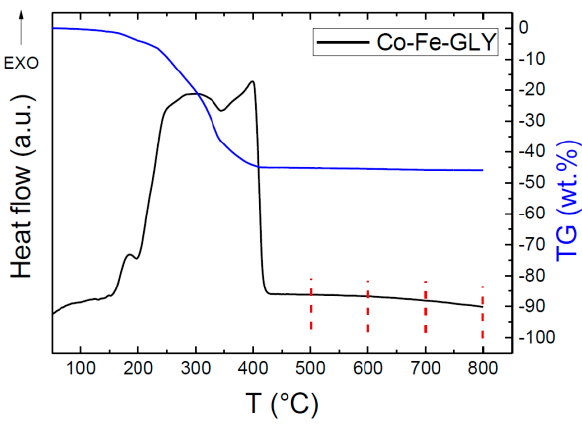
Figure 5. STA analysis of Co-Fe-GLY with marked decomposition temperatures.